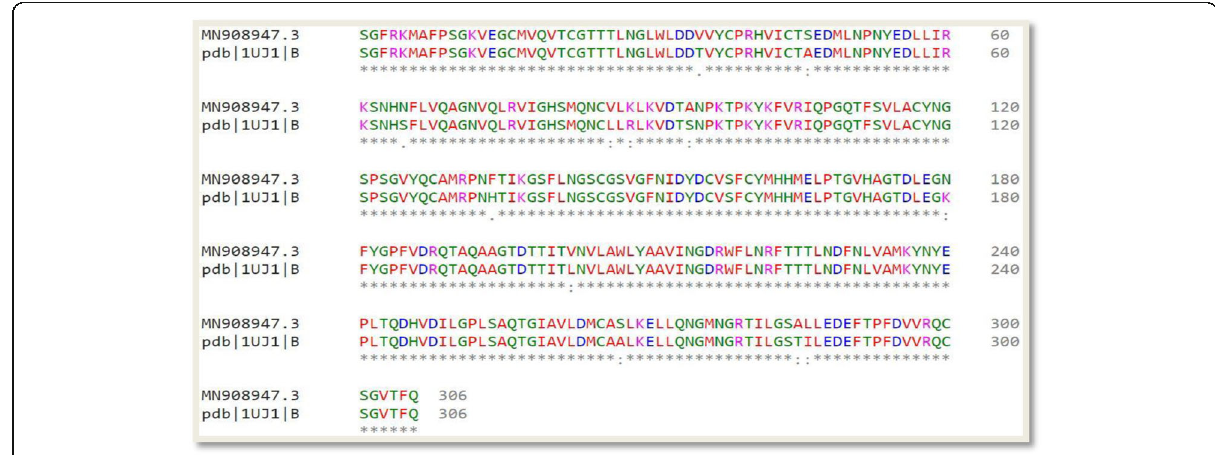
Fig. 4 Sequence alignment between the amino acid sequence of the target protein and the SARS coronavirus main